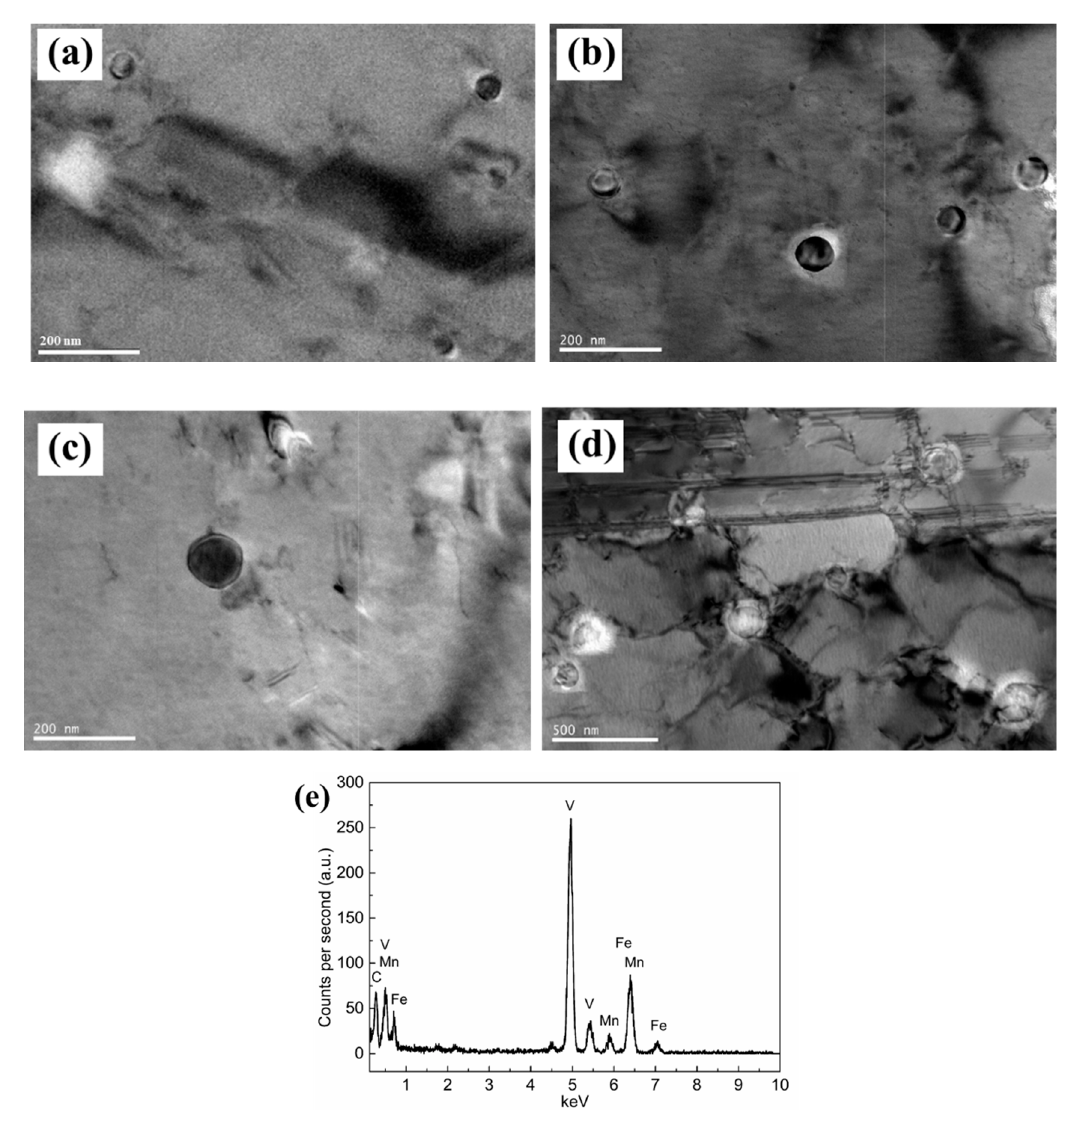
Figure 3. Transmission electron microscopy (TEM) micrograph showing the distribution of carbides aged at different temperatures: ( a ) 450 ◦ C, ( b ) 550 ◦ C, ( c ) 650 ◦ C, ( d ) 750 ◦ C, ( e ) X-ray energy-dispersion spectra (EDS) of the carbides. Table 1. The chemical composition of the vanadium carbides.